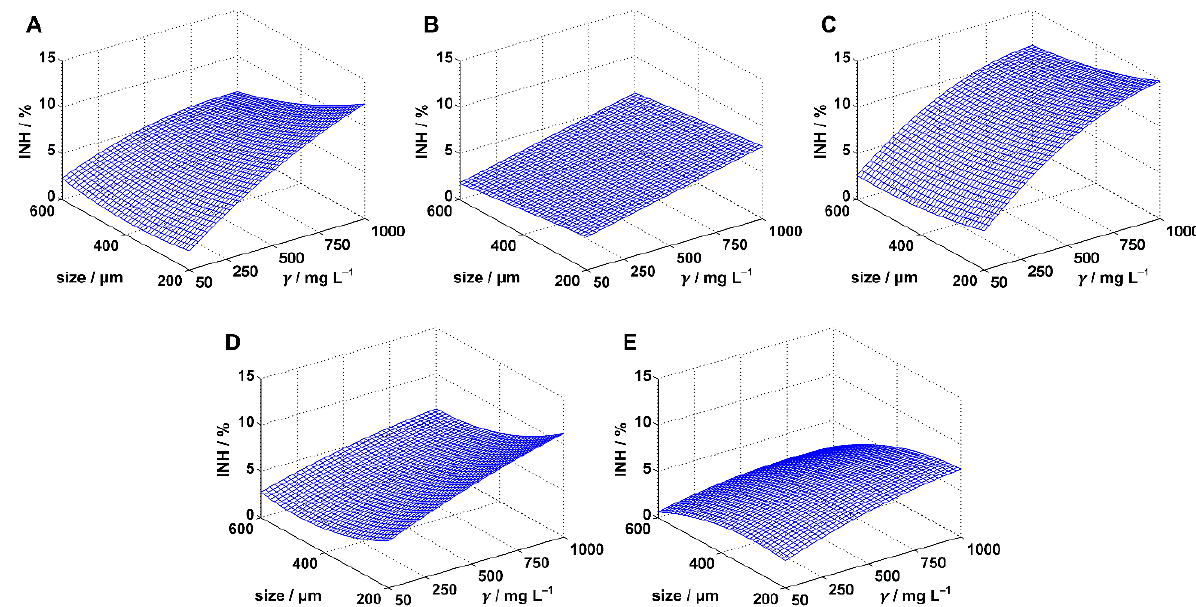
Figure 2. Inhibition surfaces estimated for Pseudomonas putida by the best regression models. The cases are: ( A ) polyethylene, ( B ) polypropylene, ( C ) polystyrene, ( D ) polyvinyl chloride, and ( E ) polyethy- lene terephthalate.